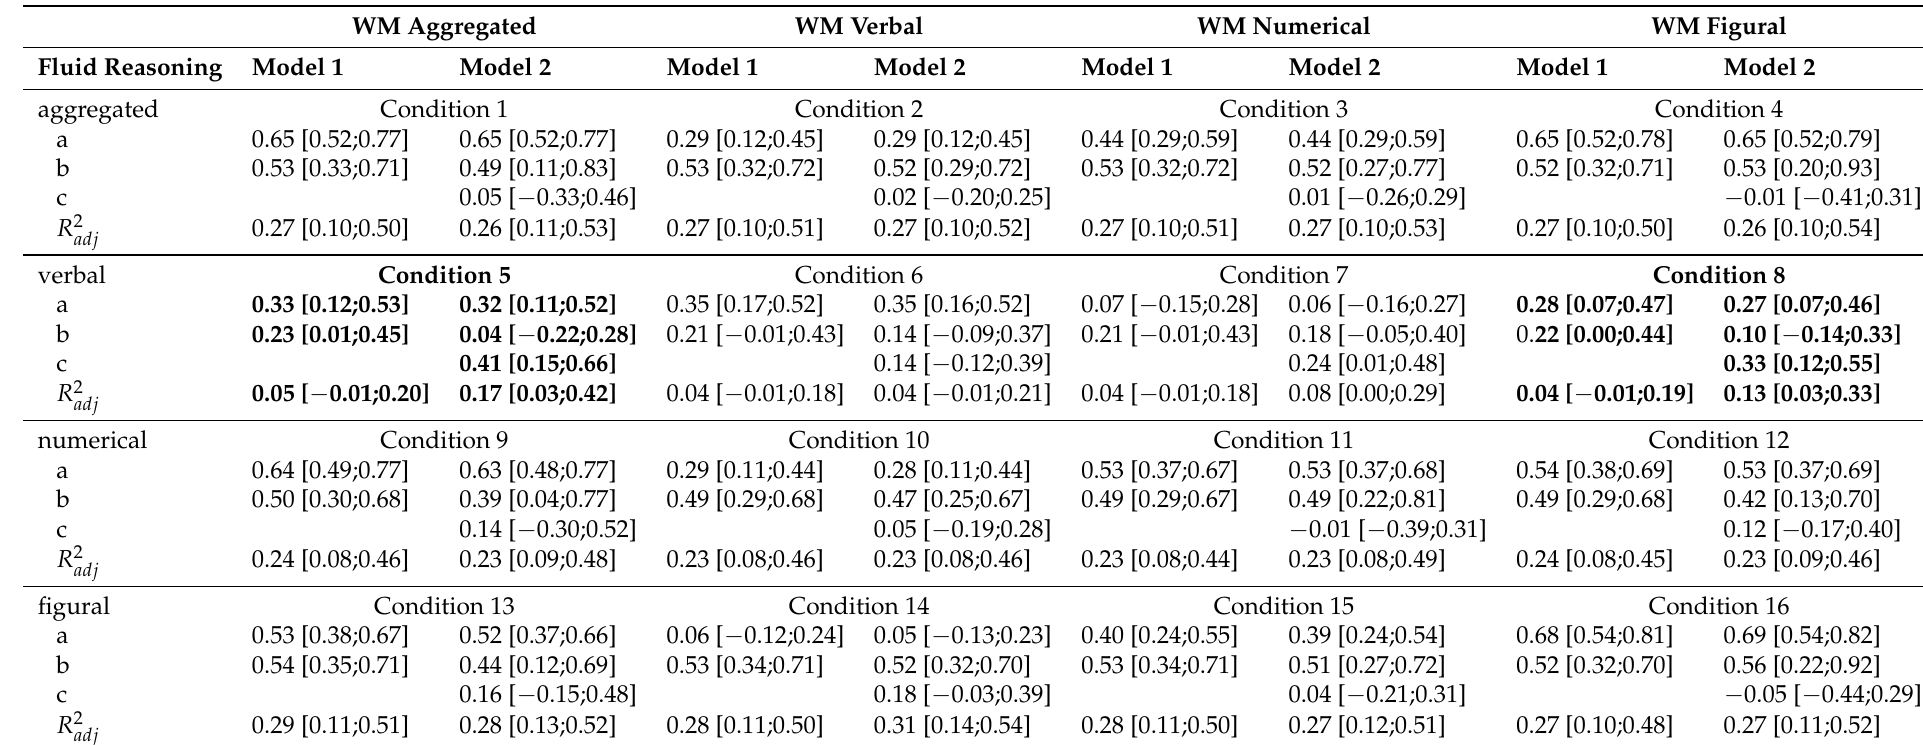
Table 2. Model parameters for different